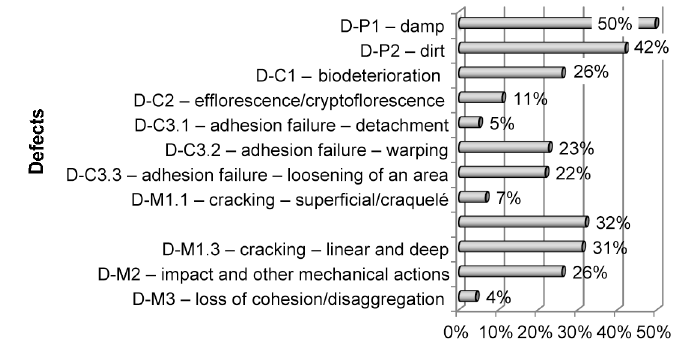
Fig. 3. Relative frequency of the defects in the